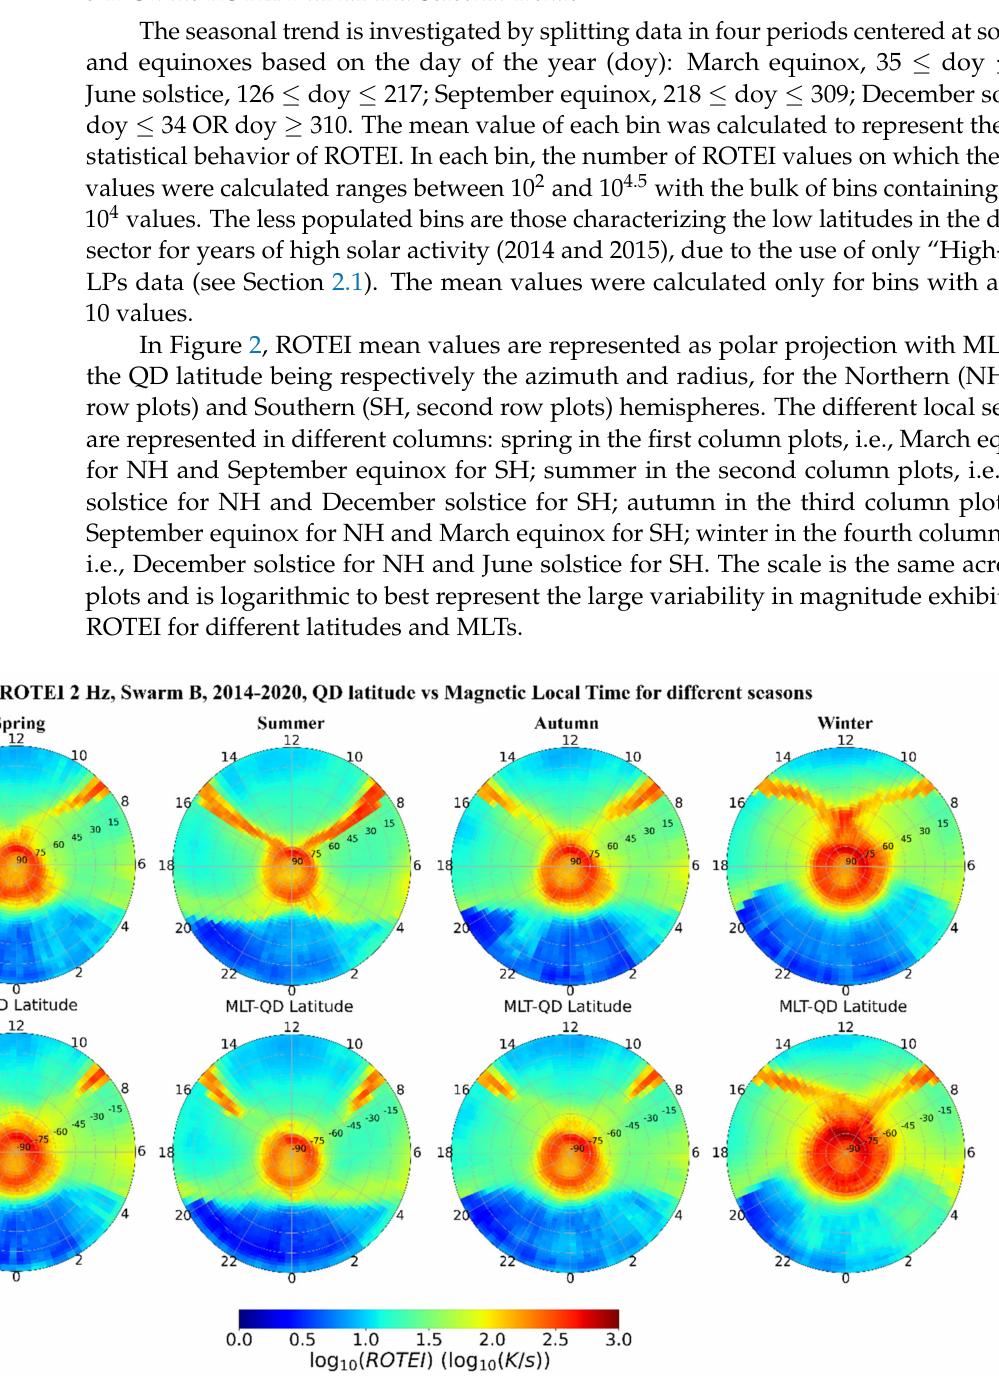
Figure 2. Statistical spatial, diurnal, and seasonal trends of ROTEI obtained from T e data measured by Swarm B from 2014 to 2020. Those represented are binned mean values in QD magnetic coordinates in polar projection; the bin size is (azimuth) 15 minutes in MLT, (radius) 2.5 ◦ in QD latitude. First row for the Northern hemisphere, second row for the Southern hemisphere. The first column plots are for the spring season, the second column for summer, the third column for autumn, and the fourth column for